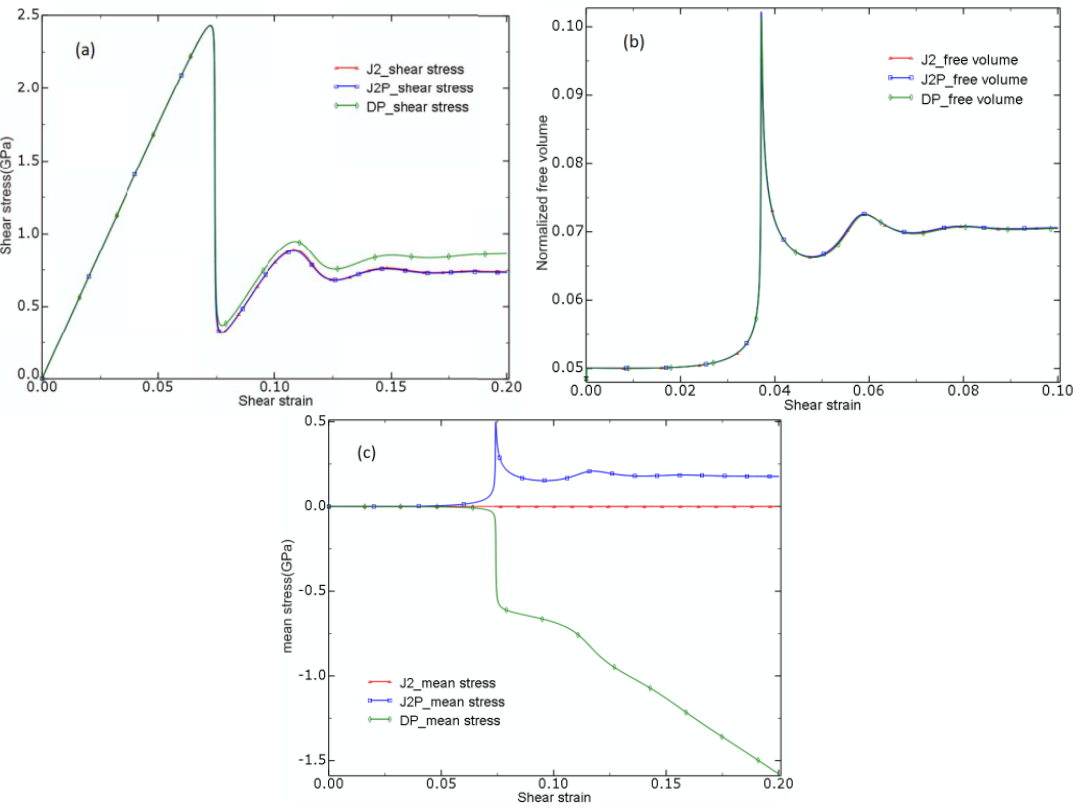
Figure 3. The results from a simple shear by the three constitutive models: ( a ) the